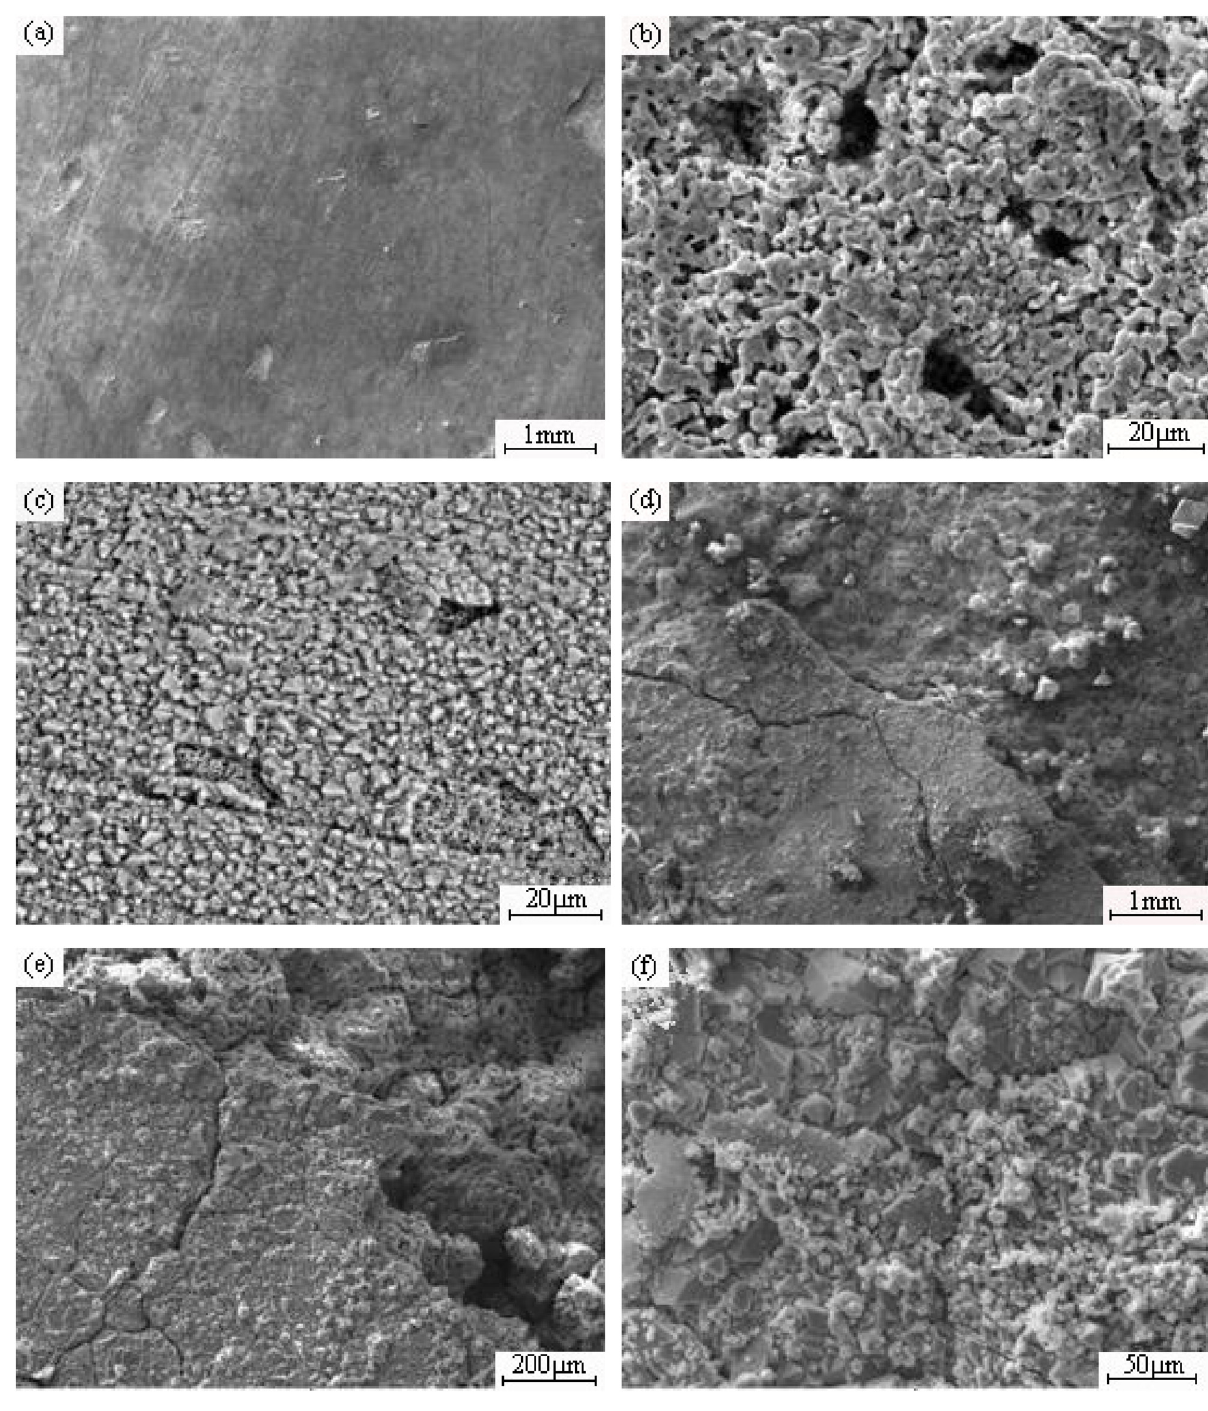
Figure 4: Surface morphologies of Inconel625 alloy after corrosion in ternary chloride molten salt at 700°C ( a – c ) and 900°C ( d – f ) for 60 h,